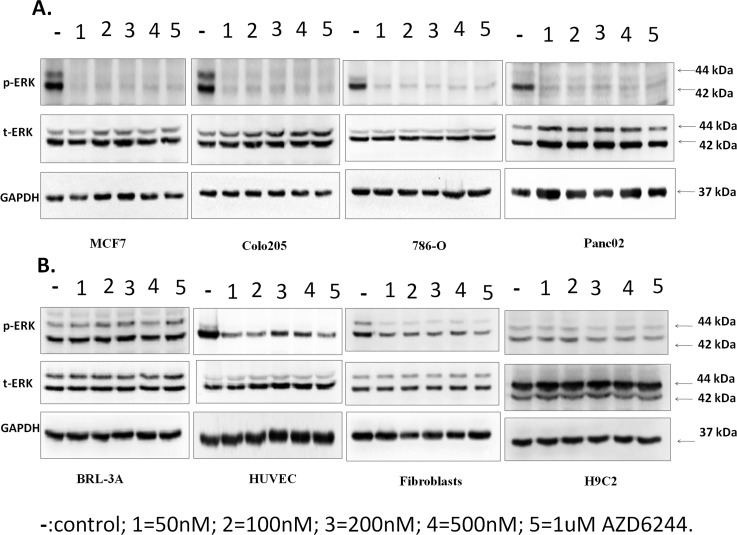
The ERK inhibition effect with AZD6244 was significant in neoplastic cells and mild in non-neoplastic cells.(A).Representative immunoblots using antibodies against phosphorylated ERK1/2 (pERK1/2) and total ERK1/2 (ERK1/2) to probe proteins extracted from MCF7, Colo205, 786-O, and Panc02 cell lysates treated with 50 nM, 100 nM, 200 nM, 500 nM, and 1μM AZD or without AZD, n = 3. (B).Representative immunoblots using antibodies against phosphorylated ERK1/2 (pERK1/2) and total ERK1/2 (ERK1/2) to probe proteins extracted from BRL-3A, HUVEC, fibroblasts, and H9C2 cell lysates treated with50 nM, 100 nM, 200 nM, 500 nM, and 1μM AZD or without AZD, n = 3.